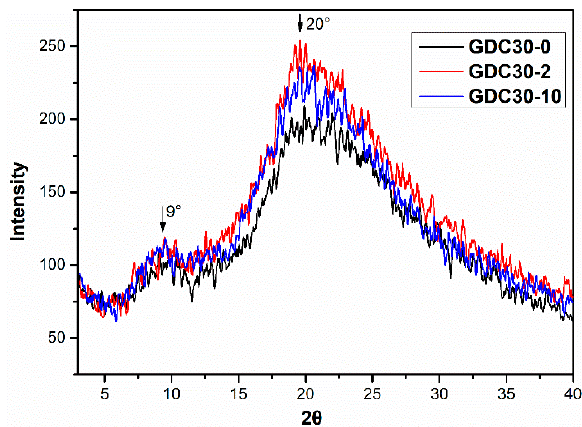
Figure 4. XRD patterns of FK films crosslinked with 0, 2, and 10 (wt %) DCMC.